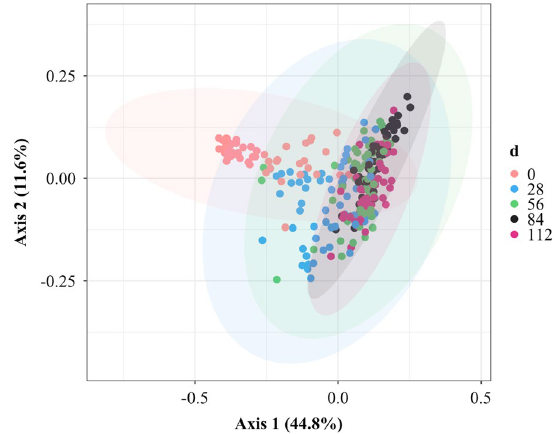
Fig. 2 Principal coordinates analysis plot illustrating the beta diversity of the calf fecal microbiota at each time point (0, 28, 56, 84, and 112 d) estimated by the Weighted UniFrac